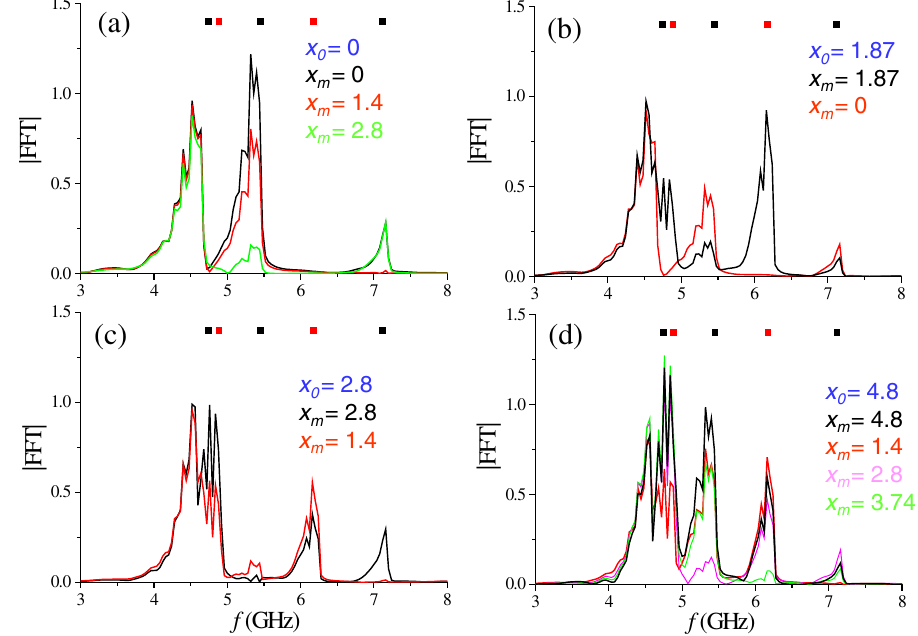
FIG. 7. The moduli of FFTs of pings emitted at transverse position x 0 , and observed at x with sharp cutoffs are clearly visible, just as for the grating with sidewalls. The empirical values for the band heads are again indicated for symmetric and antisymmetric modes. See also Table II. (a) x 0 ¼ 0 (symmetric modes only), (b) x 0 ¼ 1 : 87 , (c) x 0 ¼ 2 : 8 , and (d) x 0 ¼ 4 : 8